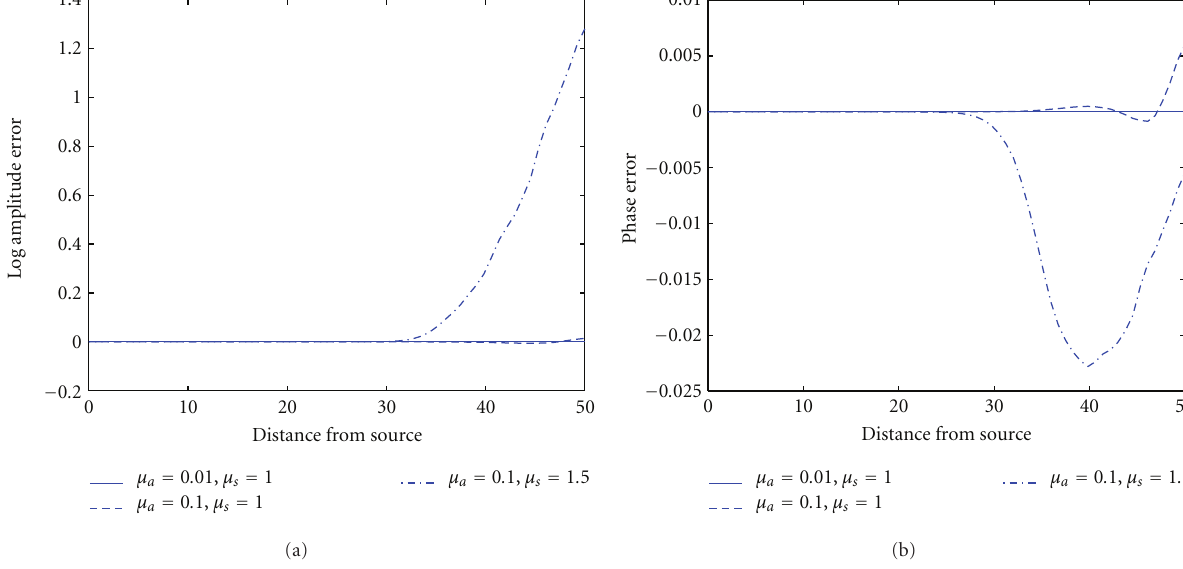
Figure 4: Single-precision arithmetic error as a function of optical coe ffi cients. Shown are the di ff erences between single and double precision results in log amplitude (a) and phase (b) along a line from the source across the cylinder, for three di ff erent combinations of absorption and scattering